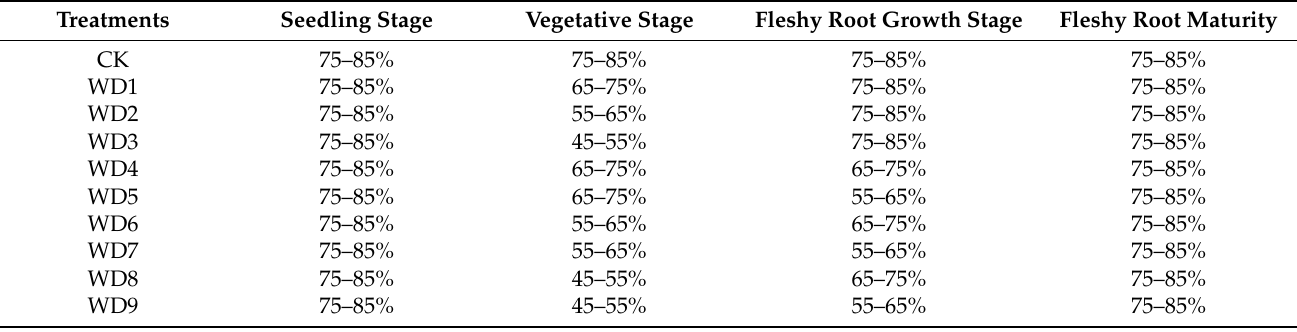
Table 1. Water-deficit irrigation treatments at different levels and different growth